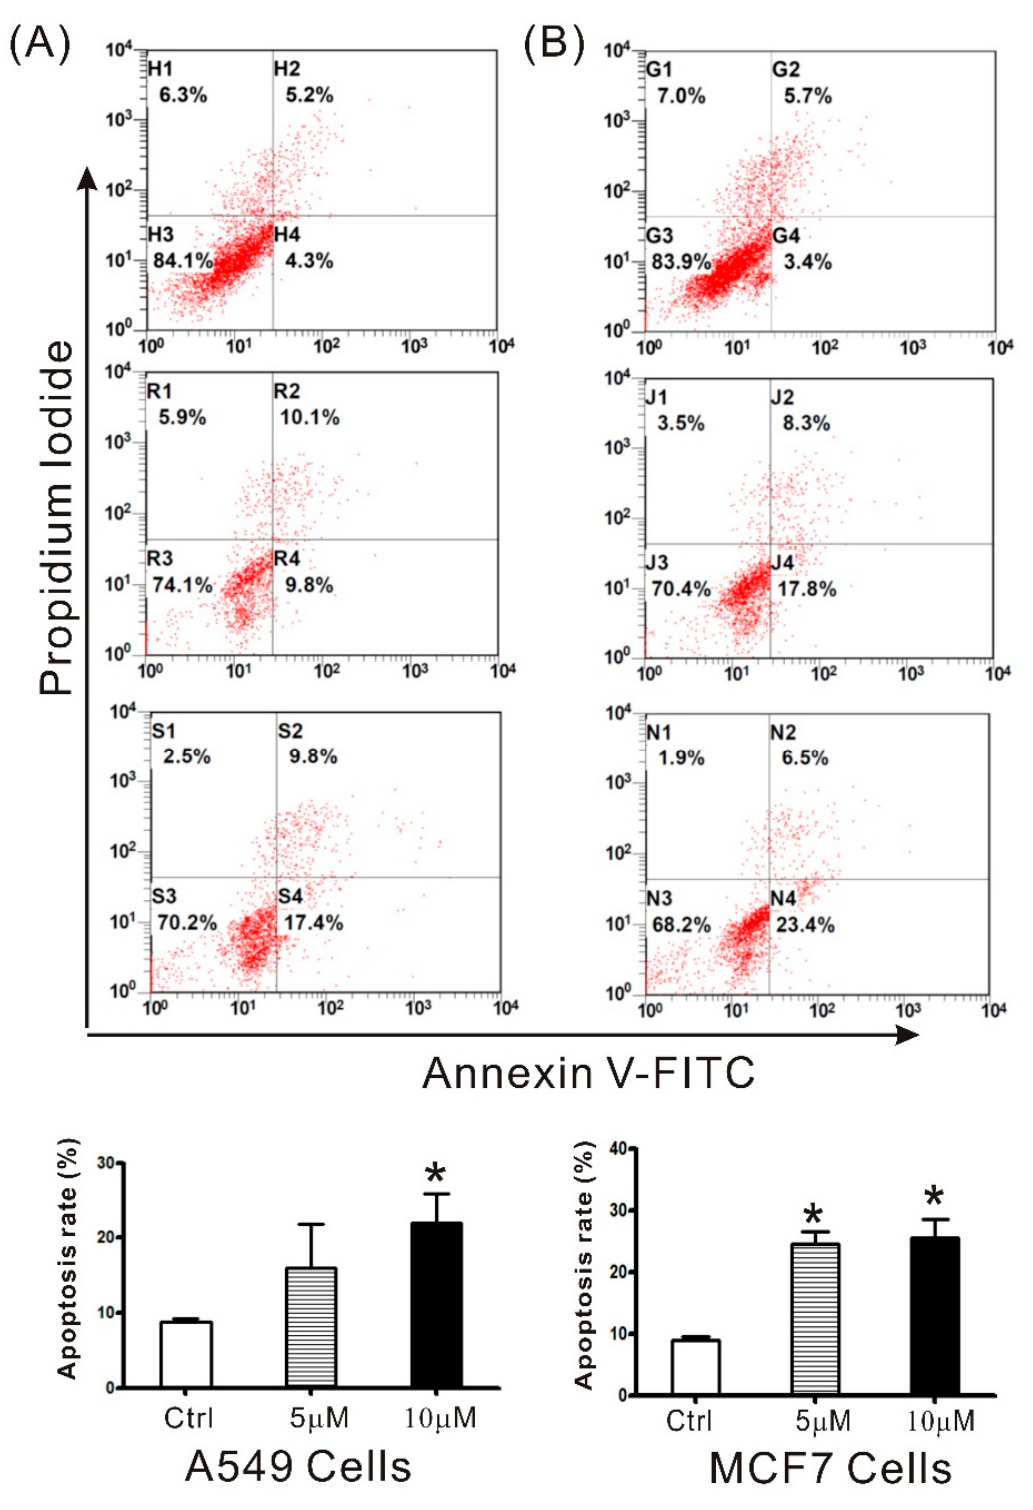
Figure 8. Compound 1 induced cell apoptosis in A549 ( A ) and MCF-7 ( B ) cells. Cells were treated with compound 1 (0, 5, 10 µ M) for 24 h. Apoptotic cells with Annexin V-FITC and PI staining were analyzed by flow cytometer. The data were expressed as means ± SEM ( n = 3). Asterisks indicate significant differences (* p < 0.05) compared to the control group.